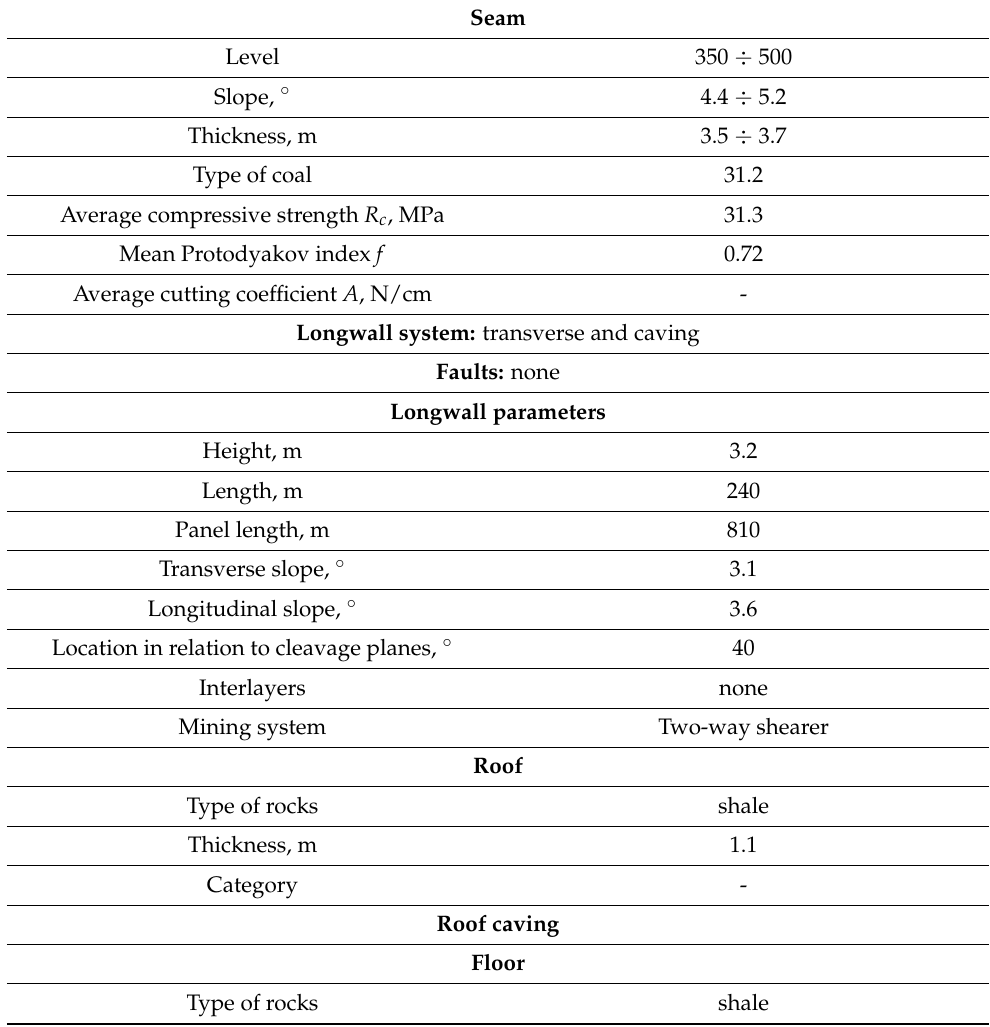
Table 1. Summary of mining-geological data and hazards in the